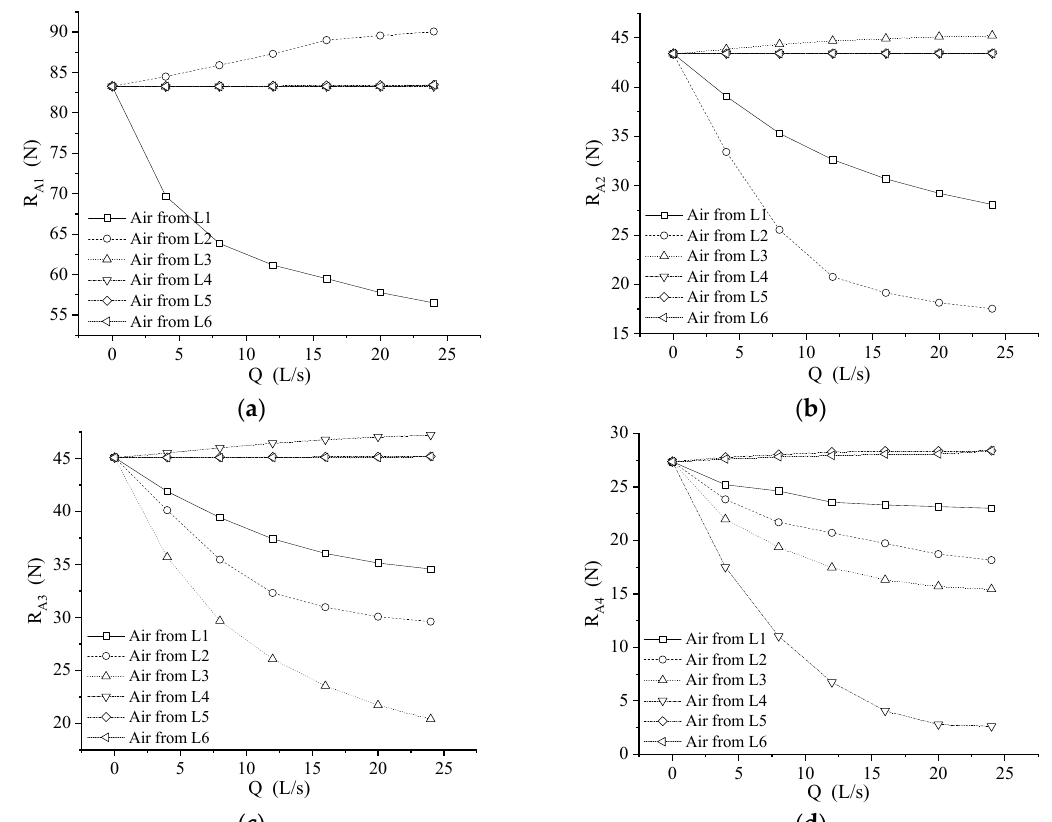
Figure 18. Resistance of different areas of the underwater body: ( a ) Total resistance of A1; ( b ) Total resistance of A2; ( c ) Total resistance of A3; ( d ) Total resistance of A4.